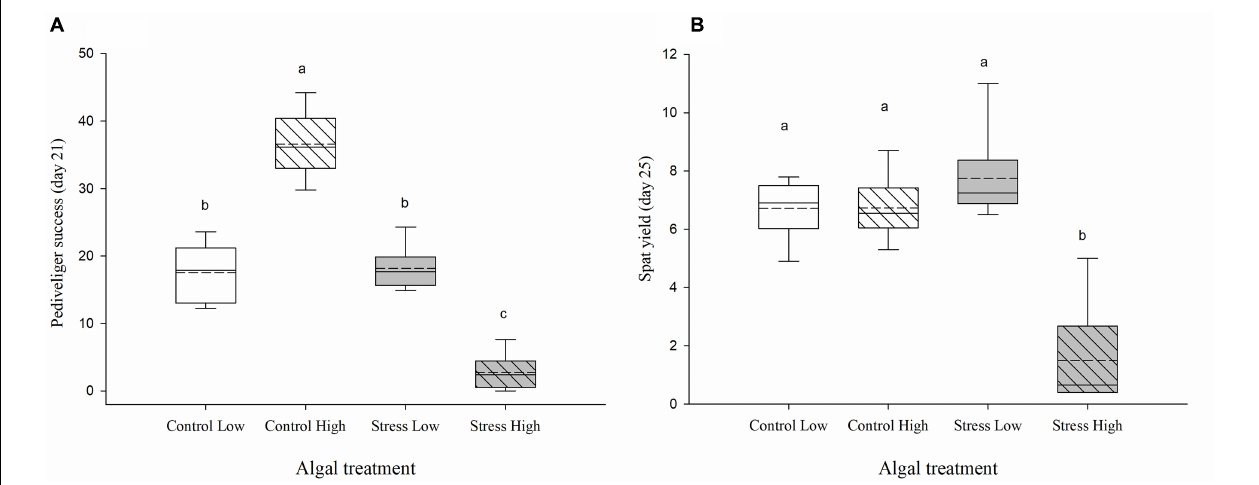
FIGURE 4 | (A) Pediveliger success and (B) final spat yield, expressed as percent, assessed before settlement on day 21 PF and day 25 PF, respectively. Crassostrea gigas larvae were exposed for 96 h to control/non-stressed algae (white), and stressed algae (gray) and subsequently reared for 7–10 days under normal feeding ration of unstressed algae (i.e., recovery conditions). Low ration (plain box) consisted of 25 cells µ L − 1 of a bispecific diet of C. calcitrans (CC) and T. lutea (T-Iso), while high ration (hashed box) consisted of 100 cells µ L − 1 of CC and T-Iso. Box plots represent the distribution of the pediveliger success (A) and spat yield (B), in percent, between the sixreplicated tanks per algal treatment. Median and mean (dashed line) values and the lower (25%) and upper (75%) quartiles are presented, while whiskers indicate the minimum and maximum values. Pediveliger success and spat yields were based on the number of umbo larvae estimated at test initiation on day 11 PF. Different letters indicate significant differences ( p ≤ 0.05) between each group (ANOVA, Tukey posthoc